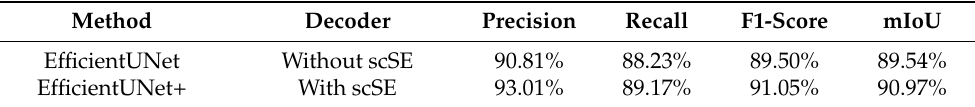
Figure 12. Building extraction results with or without the scSE. ( a ) Original image. ( b ) Ground truth. ( c ) EfficientUNet+. ( d ) EfficientUNet (without scSE). Table 4. Accuracy comparison of extraction results of different decoders.